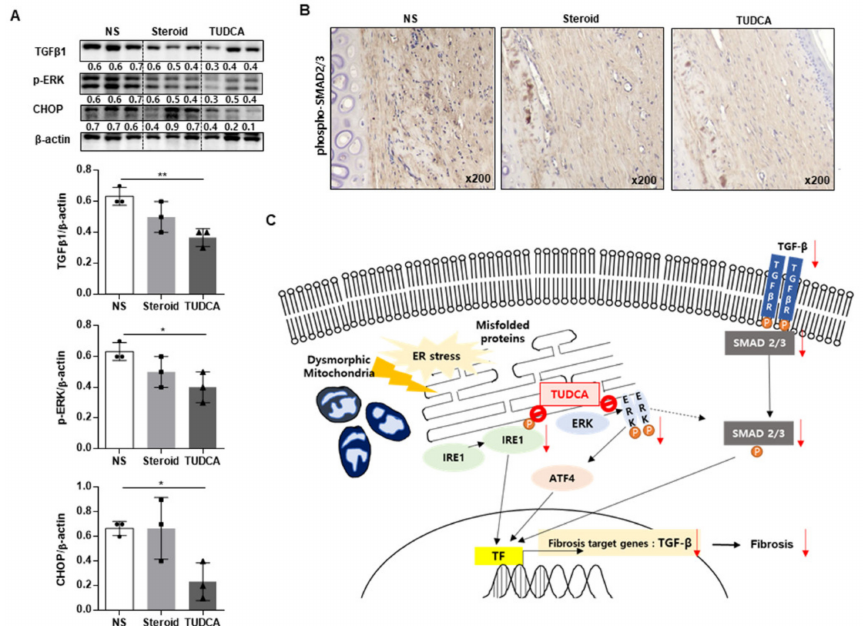
Figure 6. Effects of TUDCA on scar formation compared to saline or steroid, through the reduction of ER stress signaling TGF- β . ( A ) Western blot analysis of TGF- β 1, phospho-ERK, CHOP, and β -actin expression in rabbit ear scars in the normal saline (NS), steroid, and TUDCA groups ( n = 3 for each group). Densitometry of Western blot analysis in rabbit ear scars from the NS, steroid, and TUDCA groups ( n = 3 biological replicates). ( B ) Representative images of phospho- SMAD2/3 expression in rabbit ear scars in the normal saline, steroid, and TUDCA groups using IHC ( n = 5 for each group). ( C ) Proposed mechanism of TUDCA treatment in keloid formation. Transcription factor (TF) for TGF- β is activated through the AFT4, IRE1, and PERK pathways in keloid tissue. TUDCA inhibits the activation of IRE, ERK, and ATF4, thereby reducing TGF- β TF in the nucleus. Finally, the expression of TGF- β and fibrosis is reduced. Significance was set at p < 0.05. * p < 0.05 and ** p <